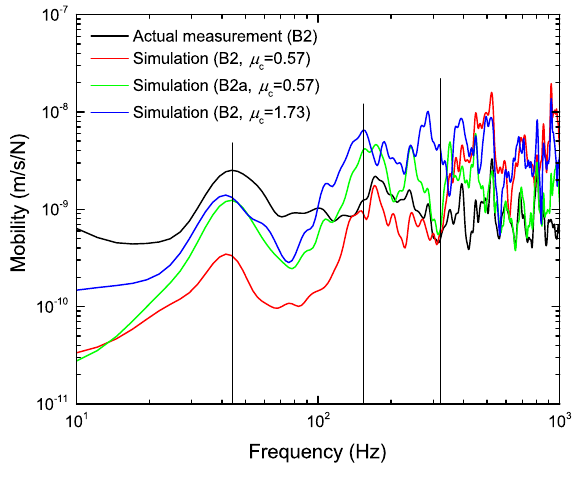
Figure 12. Frequency response function of ballast particle velocity under traffic impact load. The linear spectra are smoothed by applying a Parzen window with a bandwidth of 20